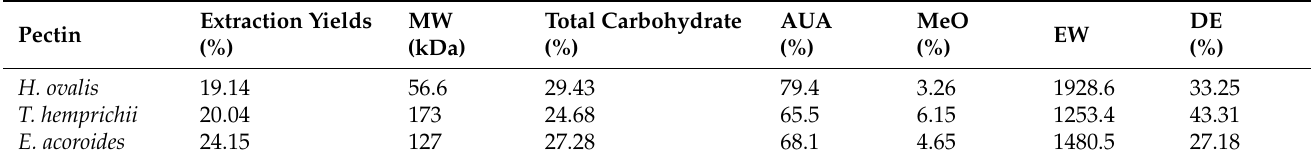
Table 1. Summary of the physicochemical characterization of pectins extracted from the examined Vietnamese seagrasses.